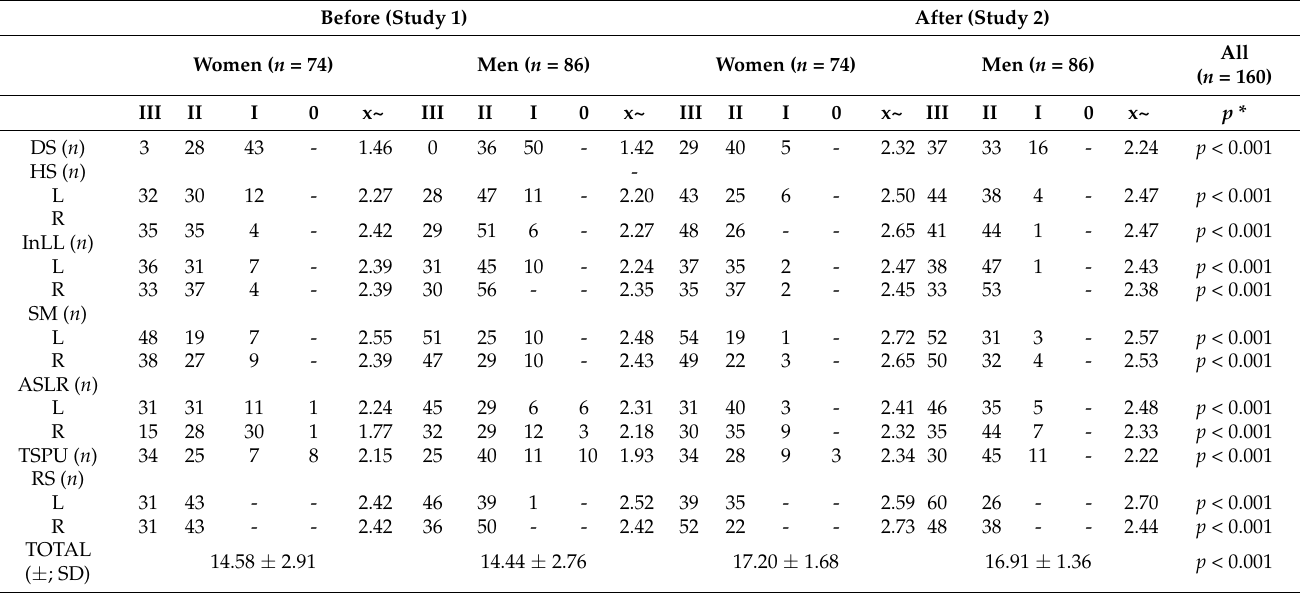
Table 2. The FMS test results before and after core stability training